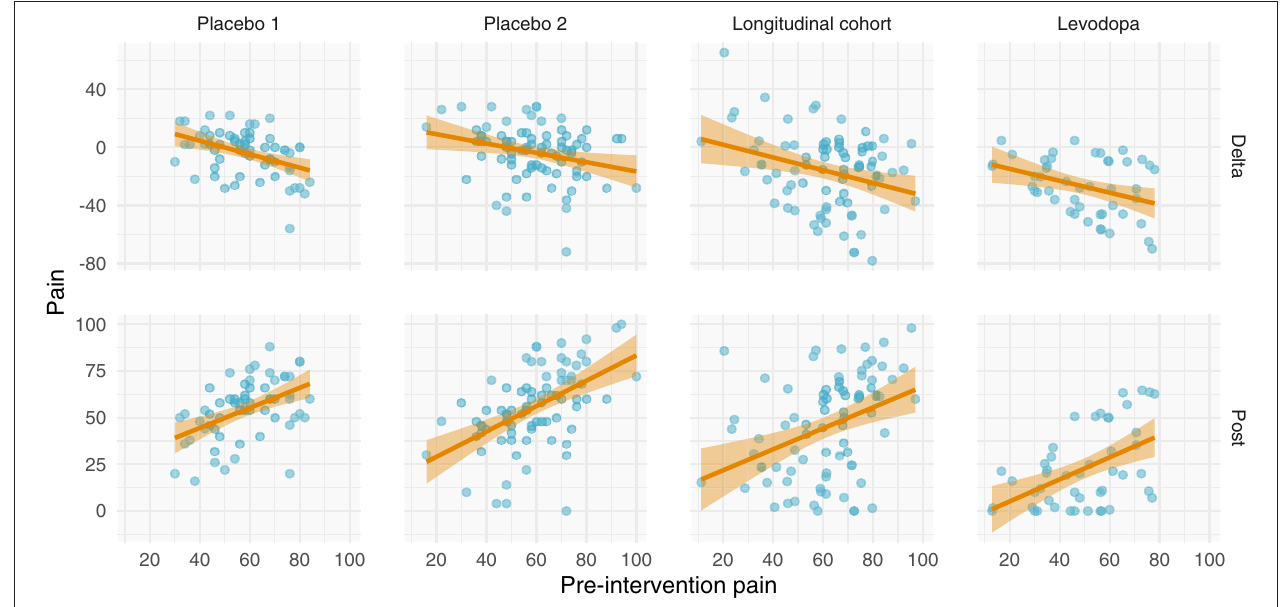
FIGURE 5 | Relationships between pre-intervention scores and change scores (top) and post-intervention scores (bottom). (Top) Relationship between pre-intervention scores and change scores. Note that most of the studies have a negative relationship. This could be explained by regression toward the mean or multiplicative effects, in addition to ceiling/floor effects. (Bottom) Relationship between pre-intervention and post-intervention pain scores across all studies. Each study shows a positive relationship between pre- and post-intervention scores; however, the Levodopa study appears to have greater variance in post-intervention scores with greater pre-intervention